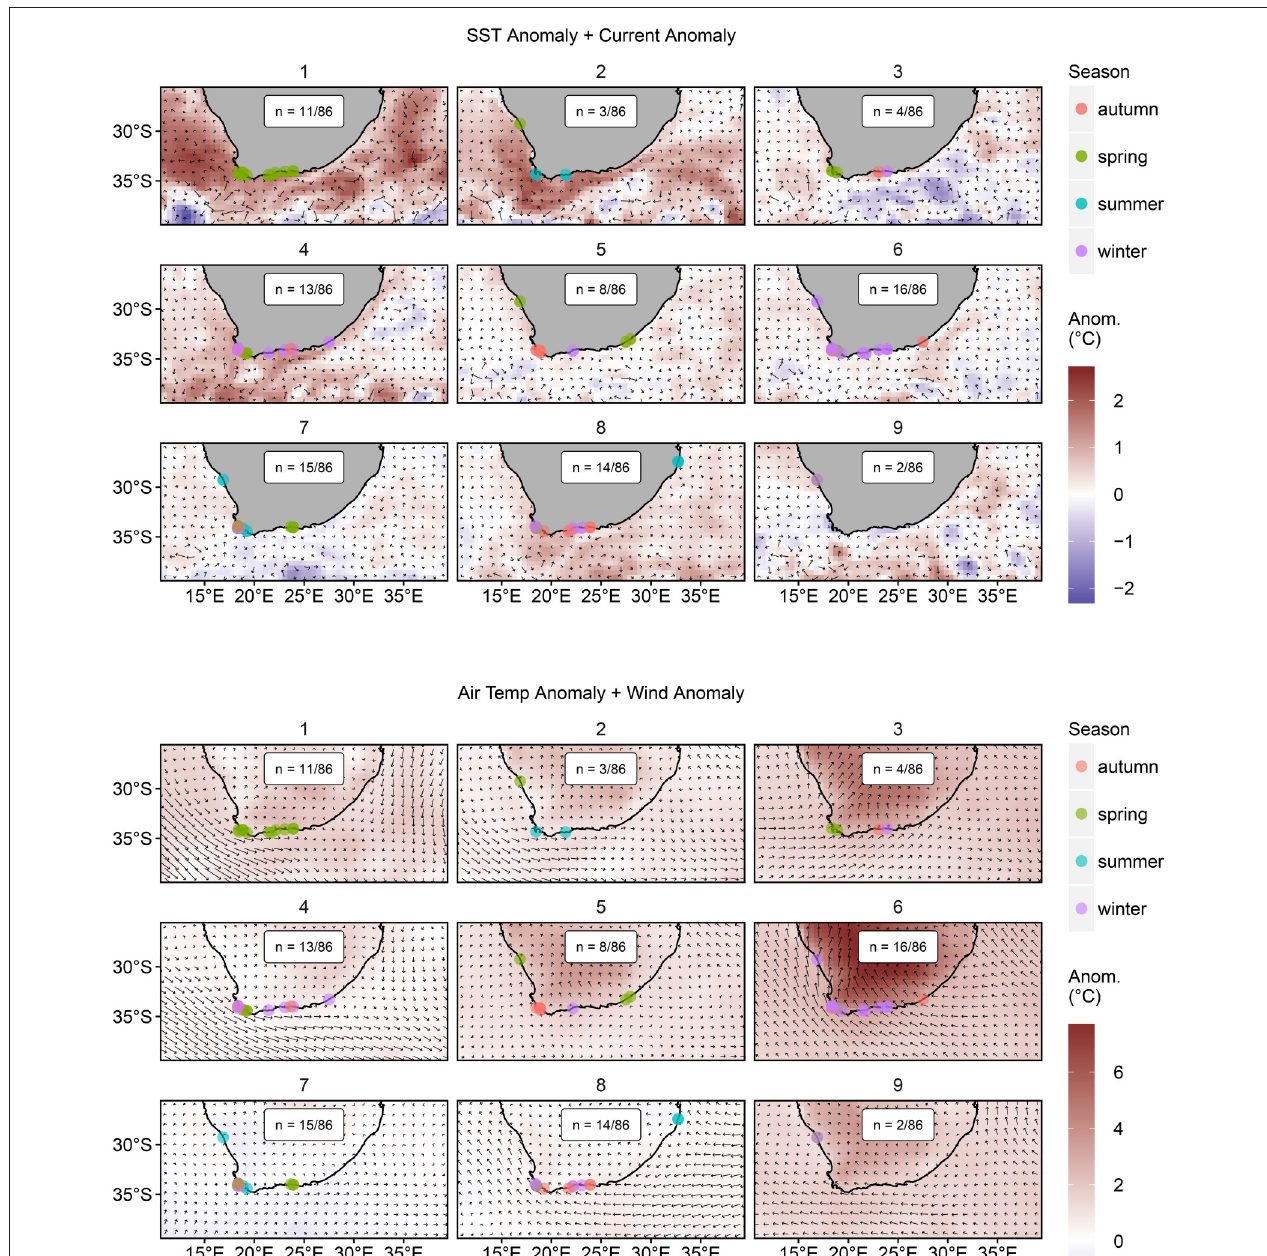
FIGURE 4 | Predominant anomalous atmospheric and oceanic patterns during coastal marine heatwaves (MHWs) as determined by a SOM. The top nine panels show the oceanic patterns while the bottom nine panels show the atmospheric patterns. The current and wind vectors are the same scale as those found in the respective atmospheric and oceanic panels of Figure 1 . The number of events clustered into each node is shown within the white label in the middle of each panel. The location of each coastal MHW within each node is shown with a dot whose color denotes the season during which that event occurred/started. Note that the temperature anomaly scales differ for the top and bottom nine